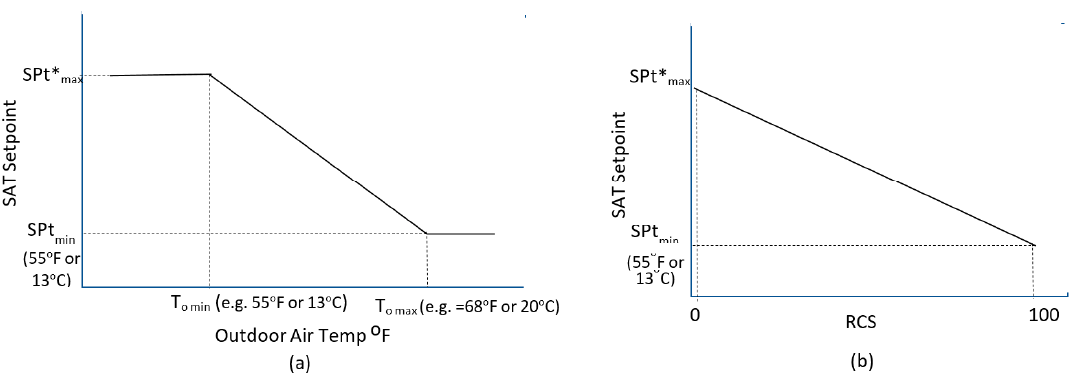
Figure 3. SAT setpoint (SPt) resetting strategies ( a ) Guideline 36 and ( b ) recommended.